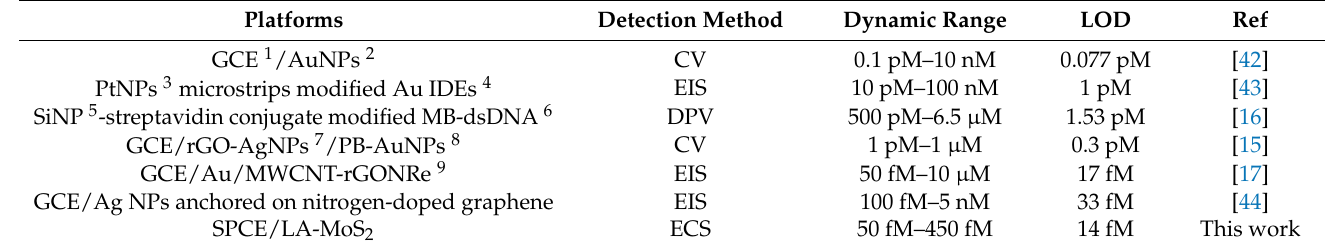
Table 1. Analytical performances of various